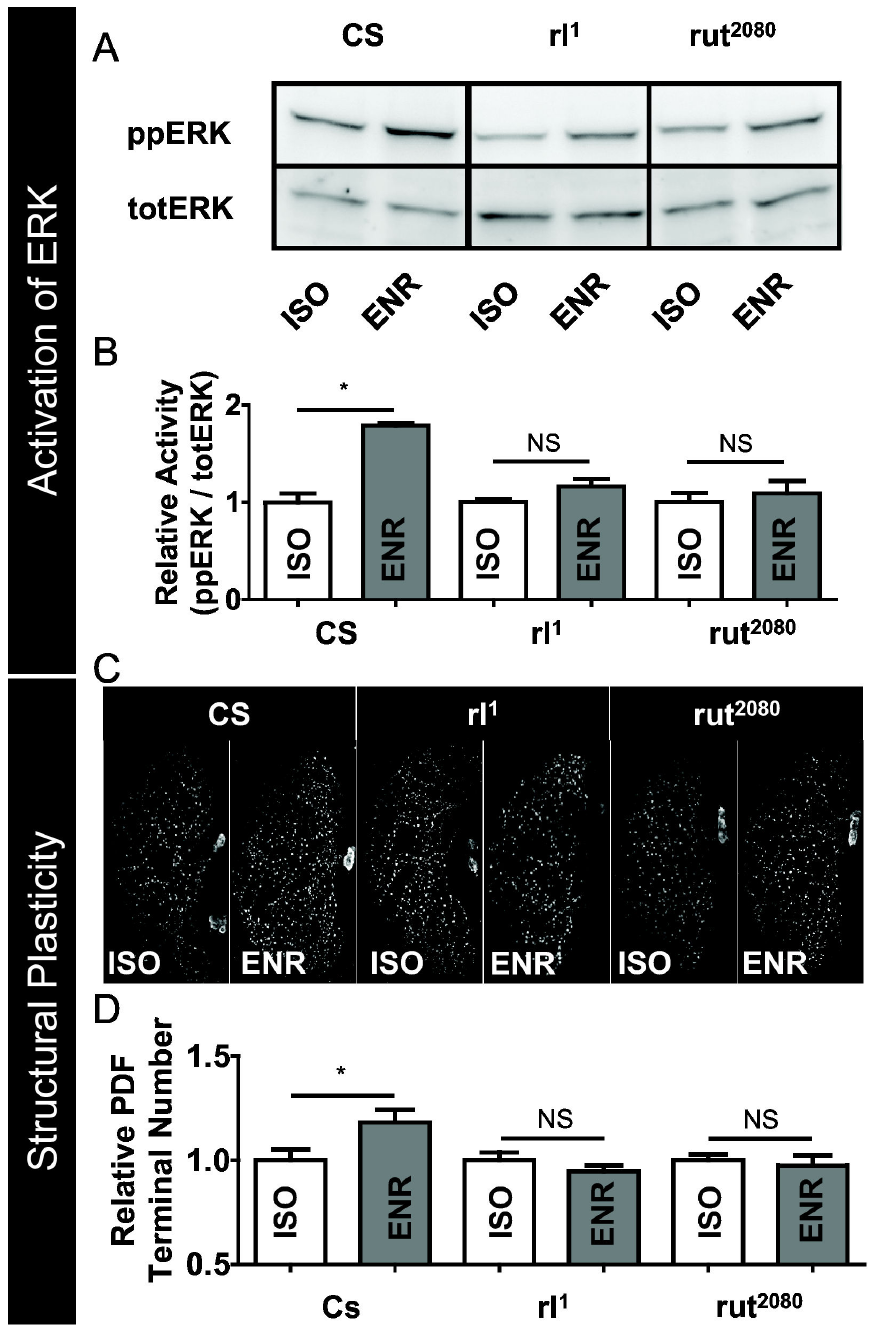
Figure 5. rl 1 and rut 2080 have deficits in ERK activation and structural plasticity in response to social enrichment. A , In contrast to Cs controls, flies mutant for rl 1 or rut 2080 do not exhibit an increase in ERK activation following social enrichment. Representative Western blot for ppERK and totERK in flies exposed to social enrichment and social isolation (4 heads/lane). B , Quantification of the Western blot in ( A ) for ppERK/totERK levels reveals a statistically significant increase in ppERK/totERK levels in the socially enriched Cs flies (p = 0.0002) with no statistical increase in ppERK/totERK levels in either rl 1 or rut 2080 mutant flies (p = 0.113 and p = 0.579, respectively, student’s t-test, * = p < 0.05). C , Immunohistochemistry for PDF in brains of Cs , rl 1 and rut 2080 flies exposed to social enrichment and social isolation. D , Quantification of PDF-positive terminals from brains in C . PDF terminals are increased following exposure to social enrichment in Cs flies p = 0.043, but not in rl 1 and rut 2080 flies, p = 0.259 and p = 0.666, respectively, student’s t-test; n=11-15/group Values normalized to the isolated siblings. doi: 10.1371/journal.pone.0081554.g005 PLOS ONE |